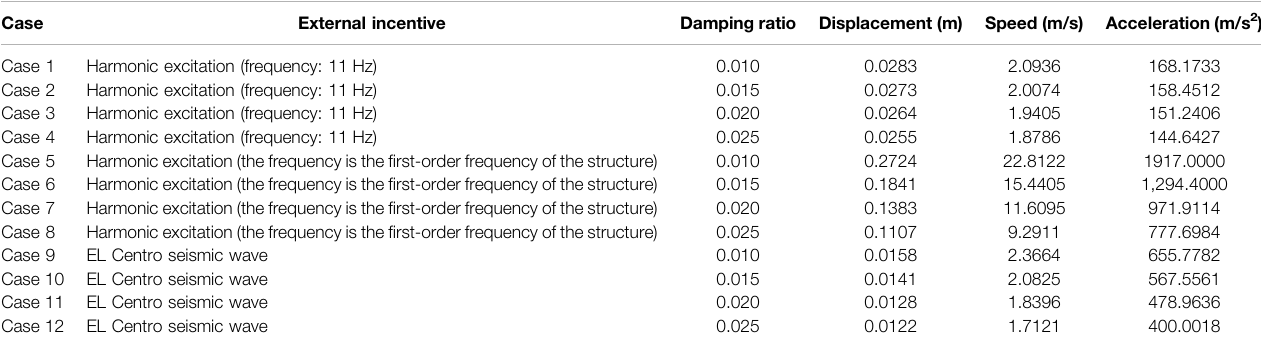
TABLE 3 | Peak values of displacement, velocity, and acceleration of structures under different